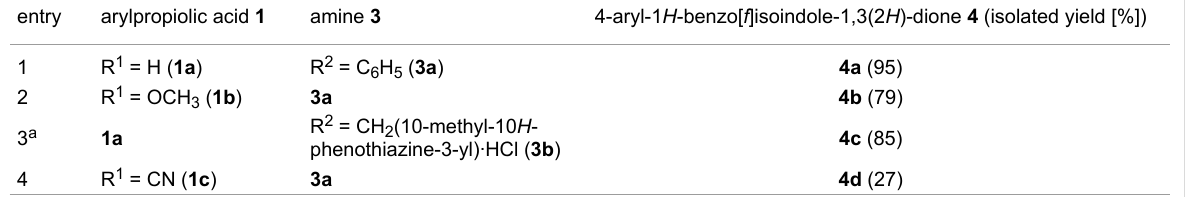
Table 4: Pseudo three-component synthesis of 1 H -benzo[ f ]isoindole-1,3(2 H )-diones 4 . entry